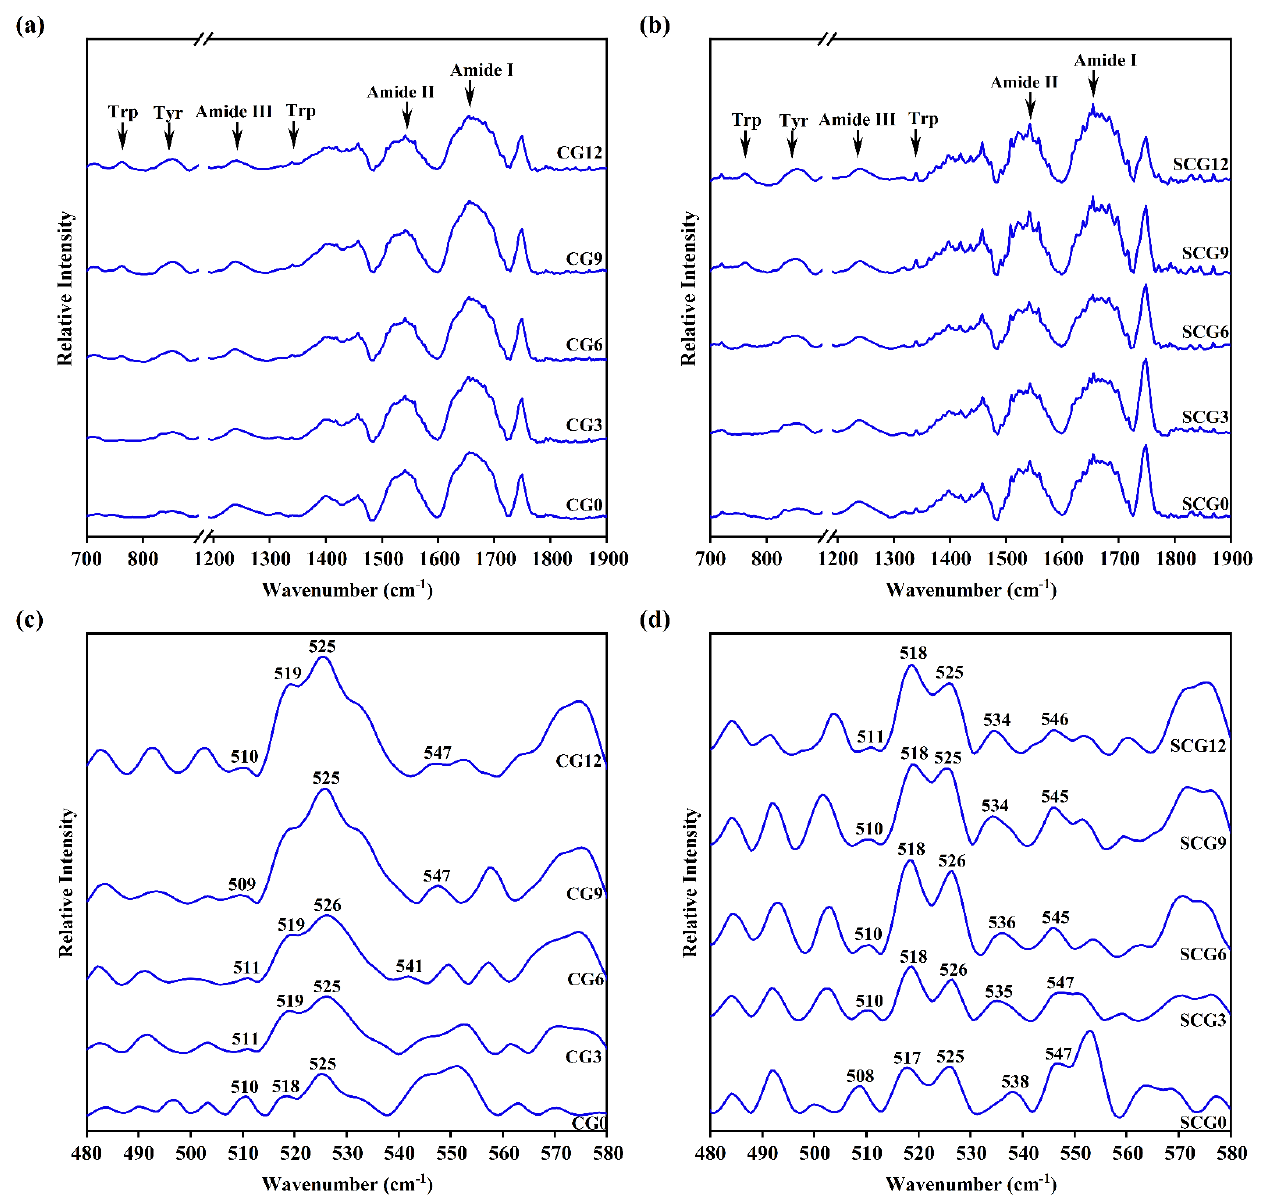
Figure 5. FT-IR spectroscopy ( a , b ) and sulfhydryl and disulfides ( c , d ) regions of starch – surimi matrix with different treatment. CG0 – CG12: cooking gels with starch content (0 – 12%); SCG0 – SCG12: setting-cooking gels with starch content (0 – 12%).